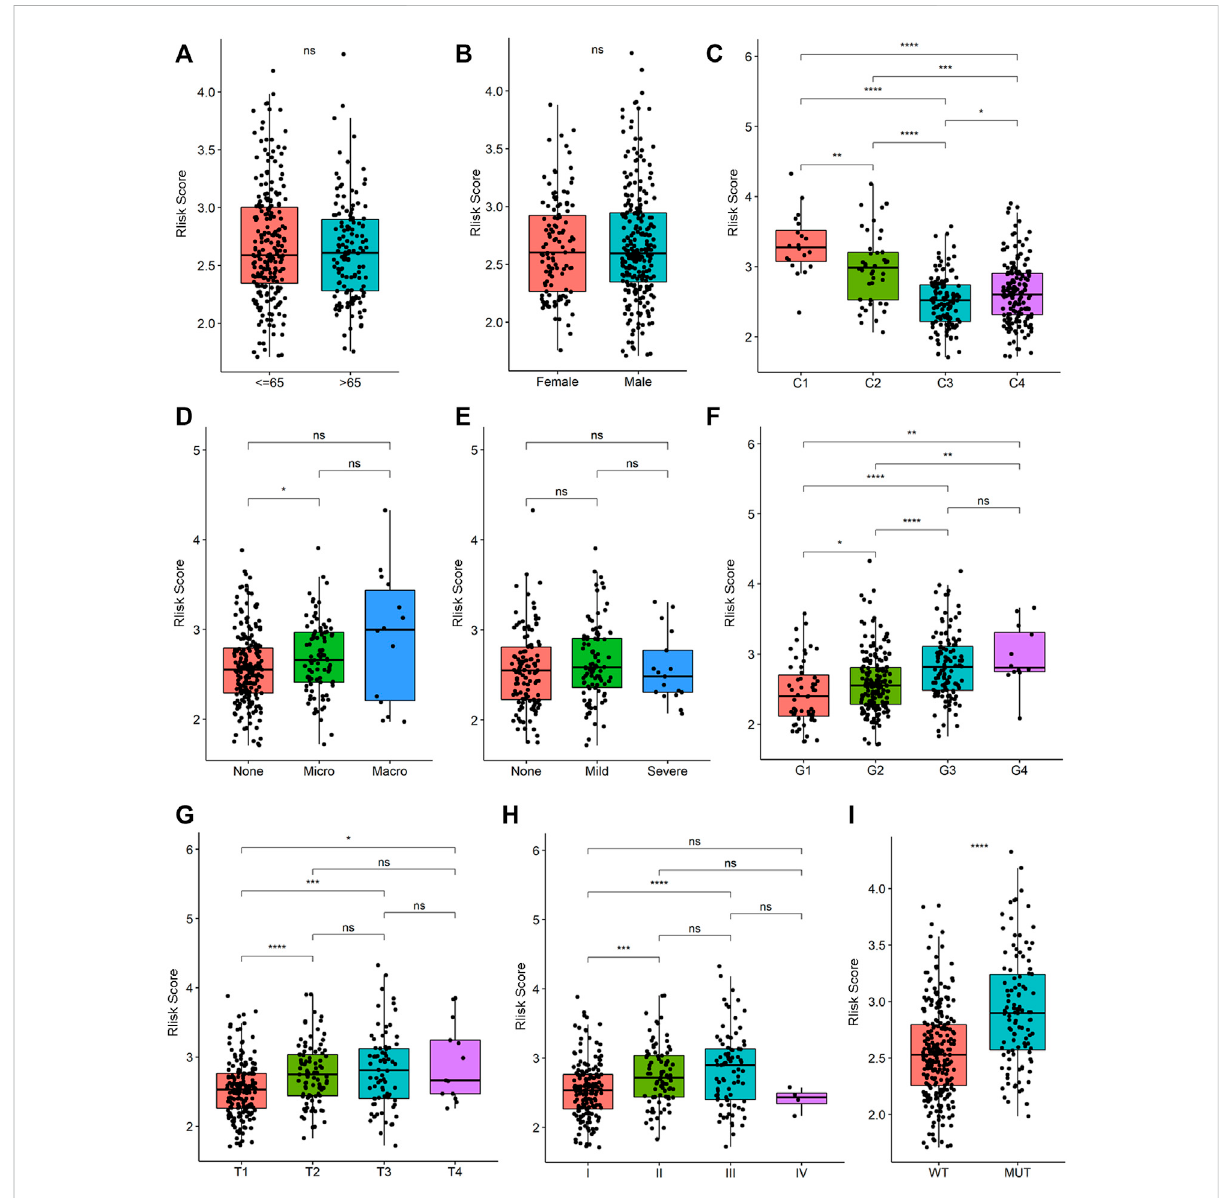
FIGURE 9 TheriskscoreinHCCsampleswithdifferentclinicaltraits. (A) Relationshipsbetweenriskscoreandagegroups( ≤ 65yearsoldvs. > 65yearsold). ns means no signi fi cance (the same below). (B) Relationships between risk score and gender (female vs. male). (C) Relationships between risk score andcollagenproportionalarea(CPA)grade(C1vs.C2vs.C3vs.C4). (D) Relationships betweenriskscoreandvascularinvasionstatus(microvascular invasion vs. macro vascular invasion). (E) Relationships between risk score and degree of hepatitis (mild hepatitis vs. severe hepatitis). (F) Relationshipsbetweenriskscoreandtumorgrade(G1vs.G2vs.G3vs.G4). (G) RelationshipsbetweenriskscoreandtumorTstage(T1vs.T2vs.T3vs. T4). (H) RelationshipsbetweenriskscoreandtumorTNMstage(Ivs.IIvs.IIIvs.IV). (I) RelationshipsbetweenriskscoreandTP53mutationstatus(wild vs.